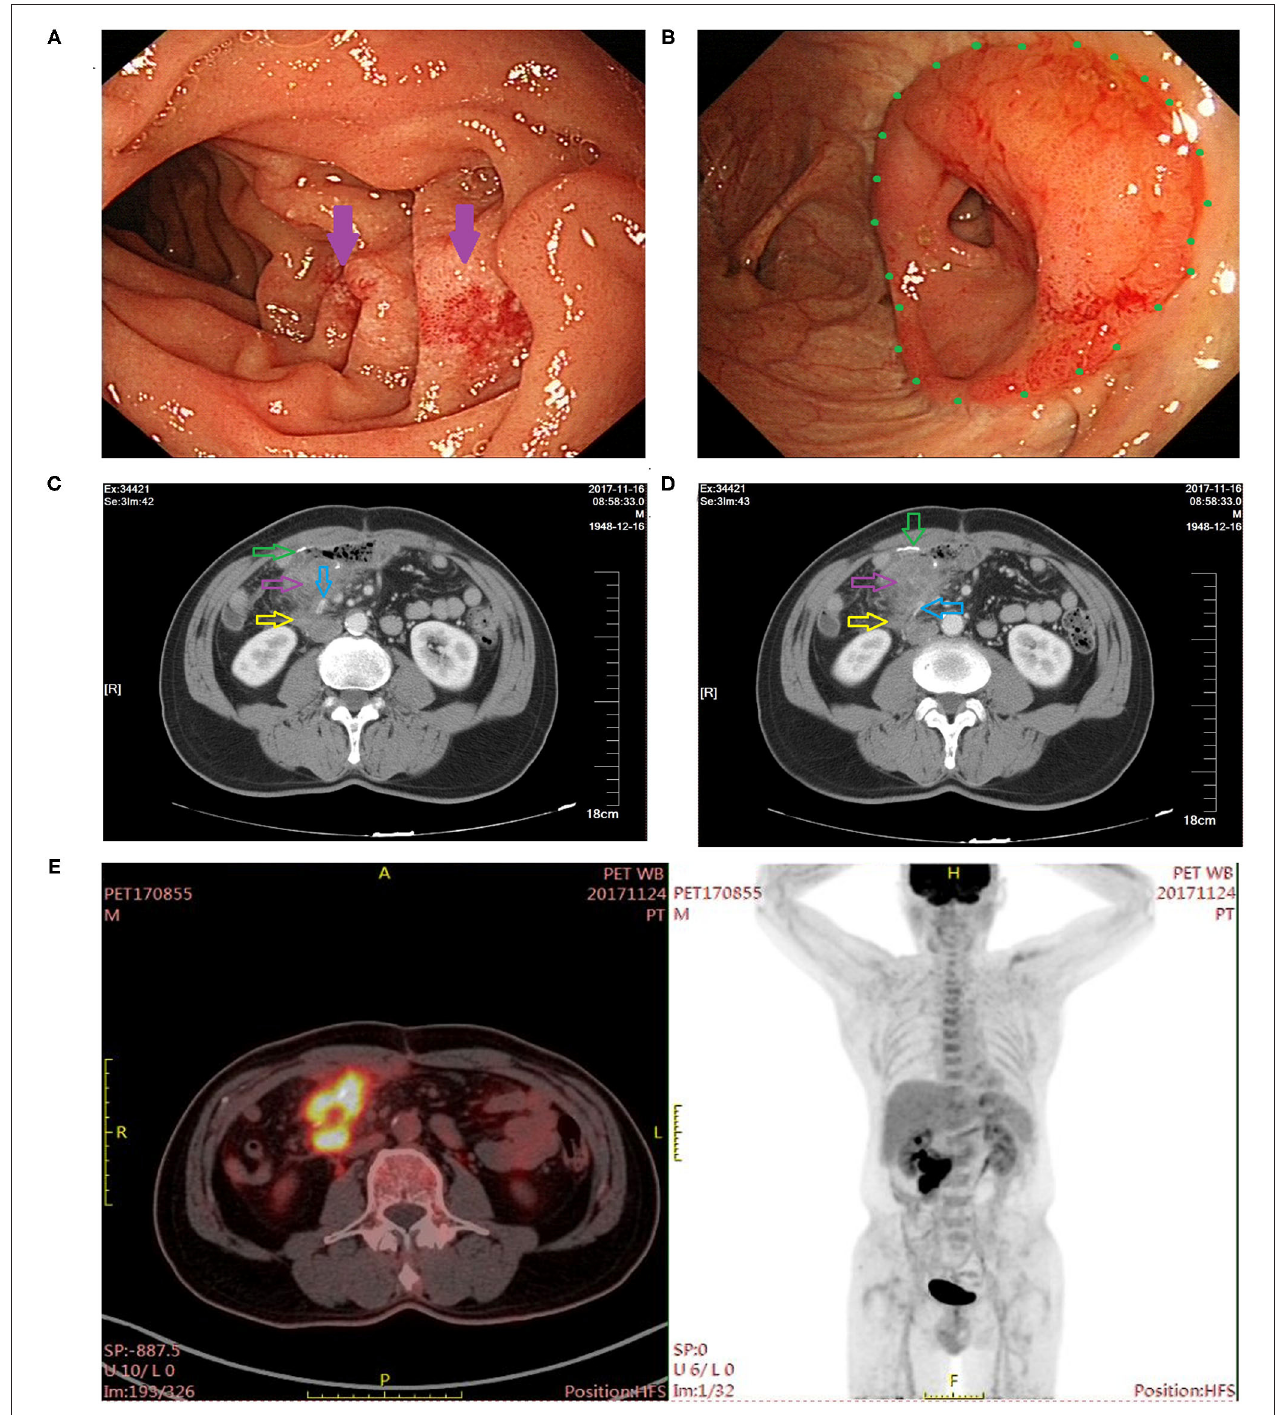
FIGURE 2 | Postoperative imaging findings at 8 months after right hemicolectomy. (A) Gastroscopy revealed inflammatory changes in the descending part of the duodenum (indicated by the purple arrow). (B) Colonoscopy showed inflammatory changes at the ileocolic anastomosis site (indicated by the green dot). (C,D) CT examination showed exudation around the ileocolic anastomosis (the green arrow indicates the ileocolic anastomosis; the purple arrow indicates inflammatory exudate; the yellow arrow indicates the duodenum; and the blue arrow indicates the vascular clip). (E) PET-CT showed high concentration of radioactivity around the